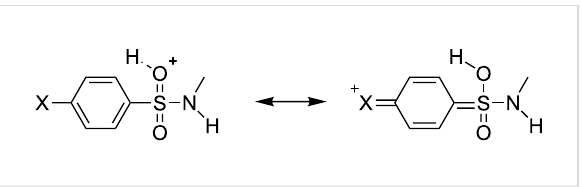
Figure 4: Correlation between p K BH+ and (A) σ or (B) σ + for com- pounds 3a – d .